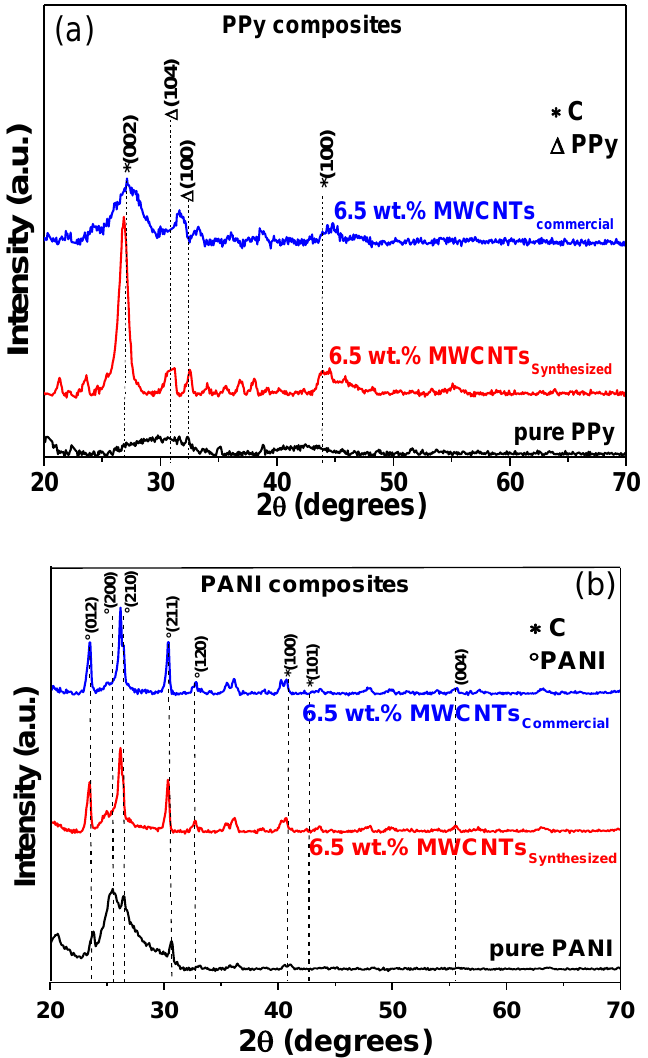
Figure 11. XRD patterns of selected ( a ) PPy/MWCNTs and ( b ) PANI/MWCNTs nanocomposites and their corresponding comparison with pure matrix and commercial MWCNTs.